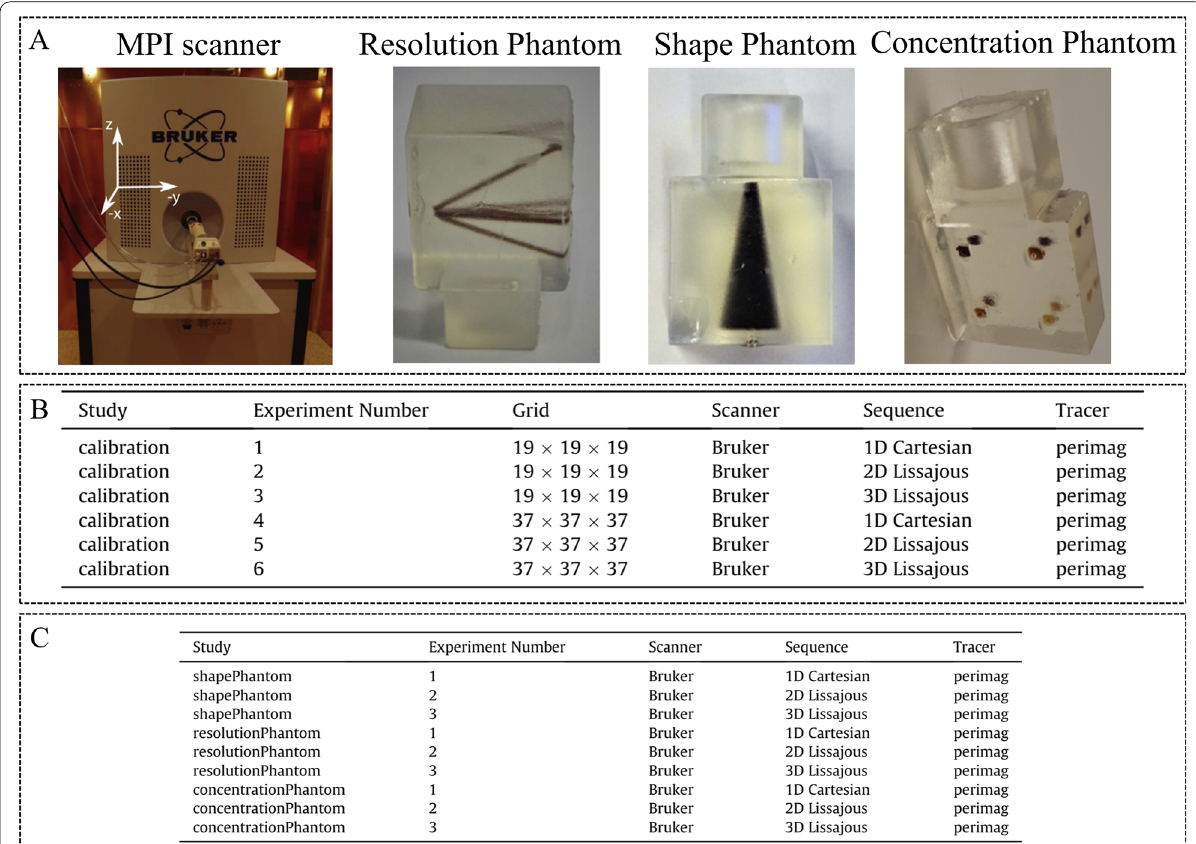
Fig. 7 Open MPI data [72]. A MPI scanner and phantoms used for measurements. B Calibration datasets. C Phantom